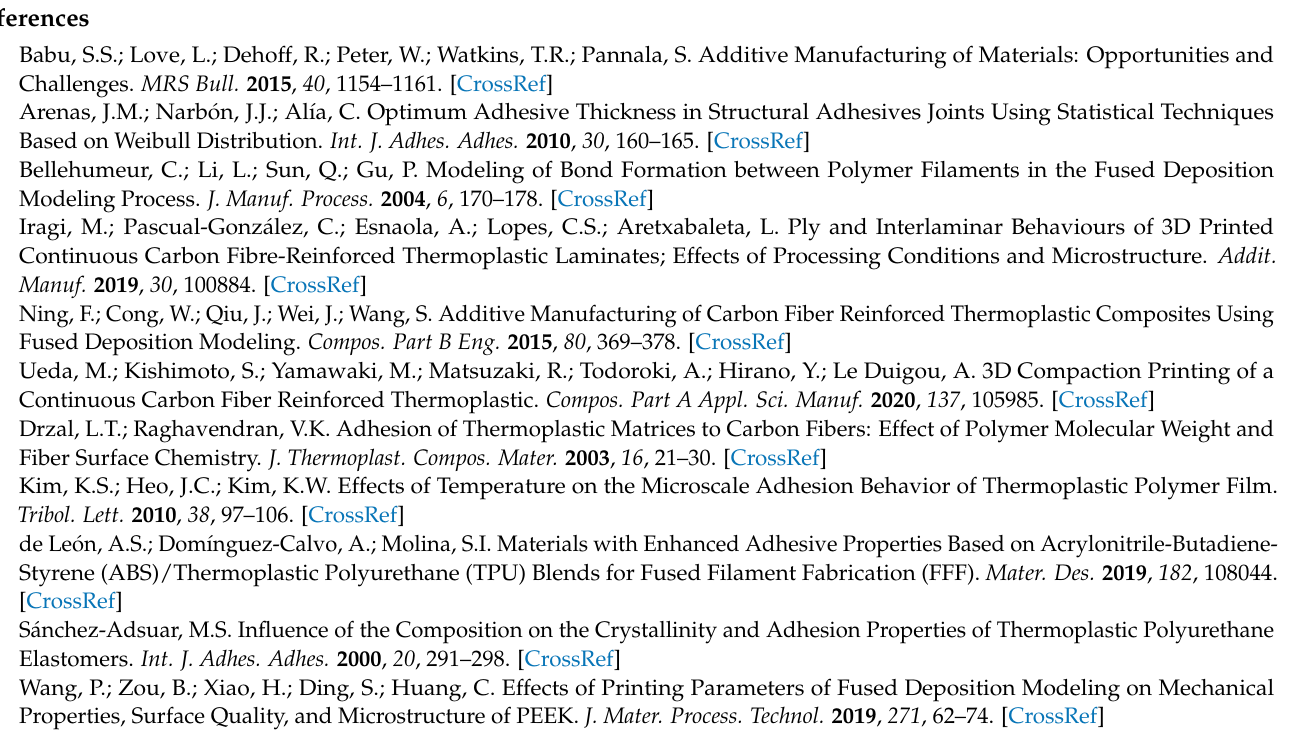
specimen; Figure S15: DSC traces for 3D printed samples undergoing the (a) first heating cycle and (b) second heating cycle. Data are summarized in Table 2 and Table S1; Figure S16: DSC traces for twin-screw extruded samples (filament) undergoing the (a) first heating cycle and (b) second heating cycle. Data are summarized in Table 2 and Figure S15; Figure S17: DSC traces for injection molded samples undergoing the (a) first heating cycle and (b) second heating cycle. Data are summarized in Table 2 and Figure S14; Figure S18: FTIR spectra of PVDF/PMMA blends processed by (a) injection-molding, (b) 3D printing and (c) twin-screw extrusion (filament); Figure S19: GPC curves of (a) PMMA and (b) PVDF for virgin (pellet) and processed (filament, injection-molded, and 3D printed) samples. Data are summarized in Tables 3 and 4; Table S1: Glass transition (T g ), melting temperature (T m ), melting enthalpy (H m ), and crystallization (X c ) for the second DSC heating